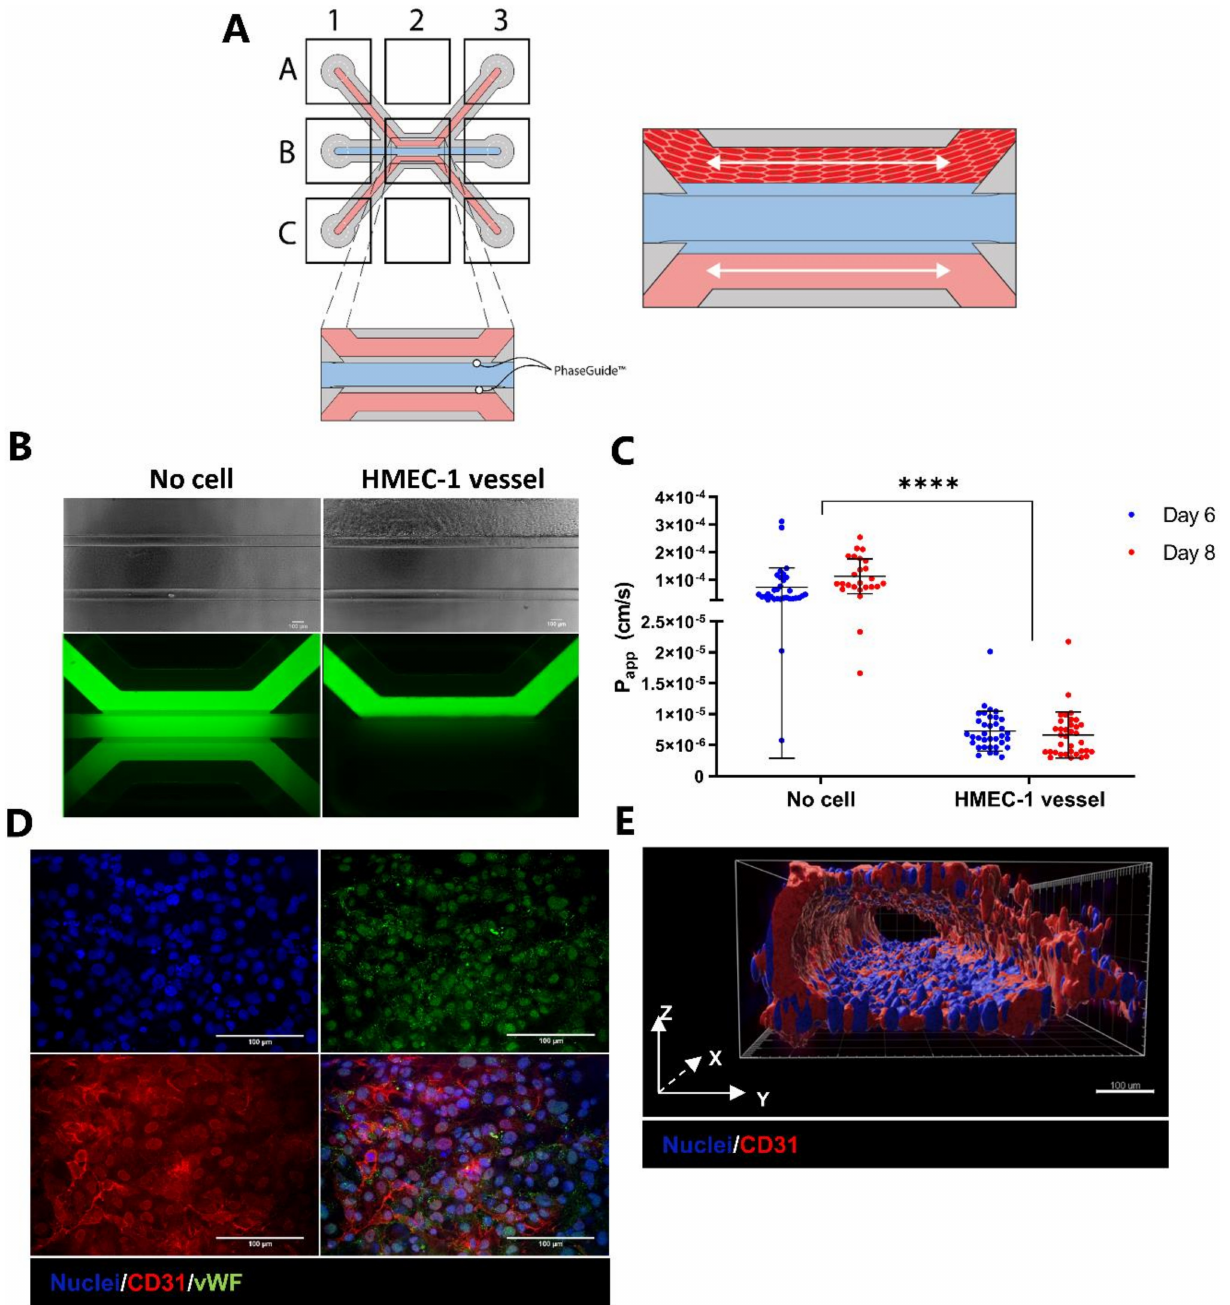
Figure 1. Endothelium on-a-chip. ( A ) A microfluidic chip, made up of a 3 by 3 grid, consists of three channels that come together in the center well (B2). The extracellular matrix (ECM, blue) is retained to the middle lane due to the PhaseGuide’s pressure barrier function. Endothelial cells can be seeded against the polymerized ECM after which a tubular structure is formed upon perfusion. ( B ) Perfusion of microfluidic chips with 10 kDa-sized FITC-dextran. The presence of a HMEC-1 vessel retains the fluorescent dextran to the top channel, demonstrating high barrier function (right). FITC-dextran has diffused throughout the chip when no vessel is present (left). ( C ) Barrier function was assessed at day 6 and day 8 after seeding by perfusing the vessels with medium containing fluorescently labeled dextran. Leakage of the fluorescent dye